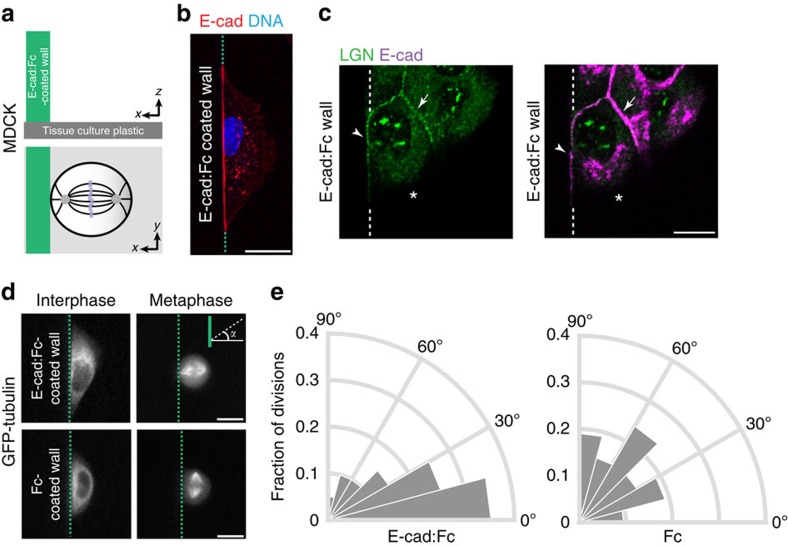
An artificial E-cadherin cell–cell junction orients epithelial cell divisions.(a) Design of the E-cadherin:Fc sidewall in which a vertical silicone sidewall is coated with E-cadherin:Fc (E-cad:Fc) and the basal surface is uncoated. (b) Localization of E-cadherin:DsRed (E-cad) at the sidewall-cell junction in MDCK cells. (c) Immunostaining of endogenous LGN in cells associated with an E-cadherin:Fc sidewall, showing that LGN is recruited to the sidewall-cell junction marked with E-cadherin (arrowhead), similar to native cell–cell adhesions (arrow) in the monolayer, whereas LGN is absent from the free membrane (asterisk). (d,e) GFP-tubulin expressing MDCK cells associated with E-cad:Fc (n=20) and Fc control (n=21) sidewalls, with rose diagram quantification of the mitotic spindle angle relative to the sidewall. See Supplementary Fig. 3f for unbinned data. Scale bars, 10 μm. Quantified data were pooled from four independent experiments.